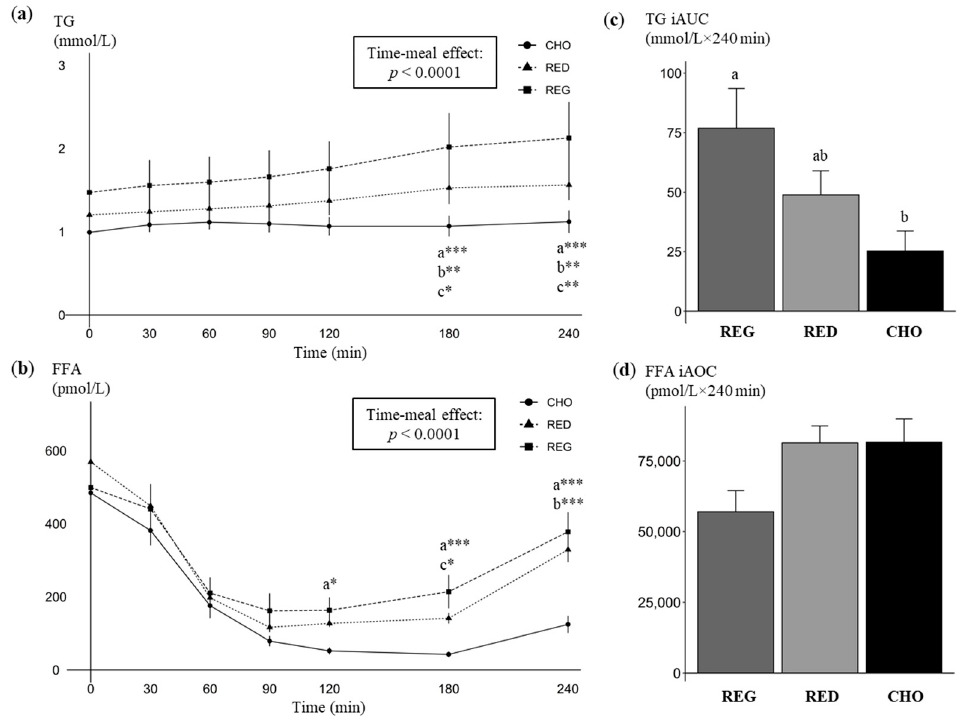
Figure 3. Postprandial blood responses of triglycerides (TG) and free fatty acids (FFA) after intake of regular-fat cheese (REG), reduced-fat cheese (RED) or carbohydrate-rich (CHO) meals ( n = 37). ( a , b ) Unadjusted mean ± SEM of TG ( a ) and FFA ( b ). Results were analysed by linear mixed model including a time-meal interaction, time and meal as fixed effects, participant as random effect and adjustments for age, sex, body mass index and fasting value. ( a , b ) Time-meal interactions were observed for TG and